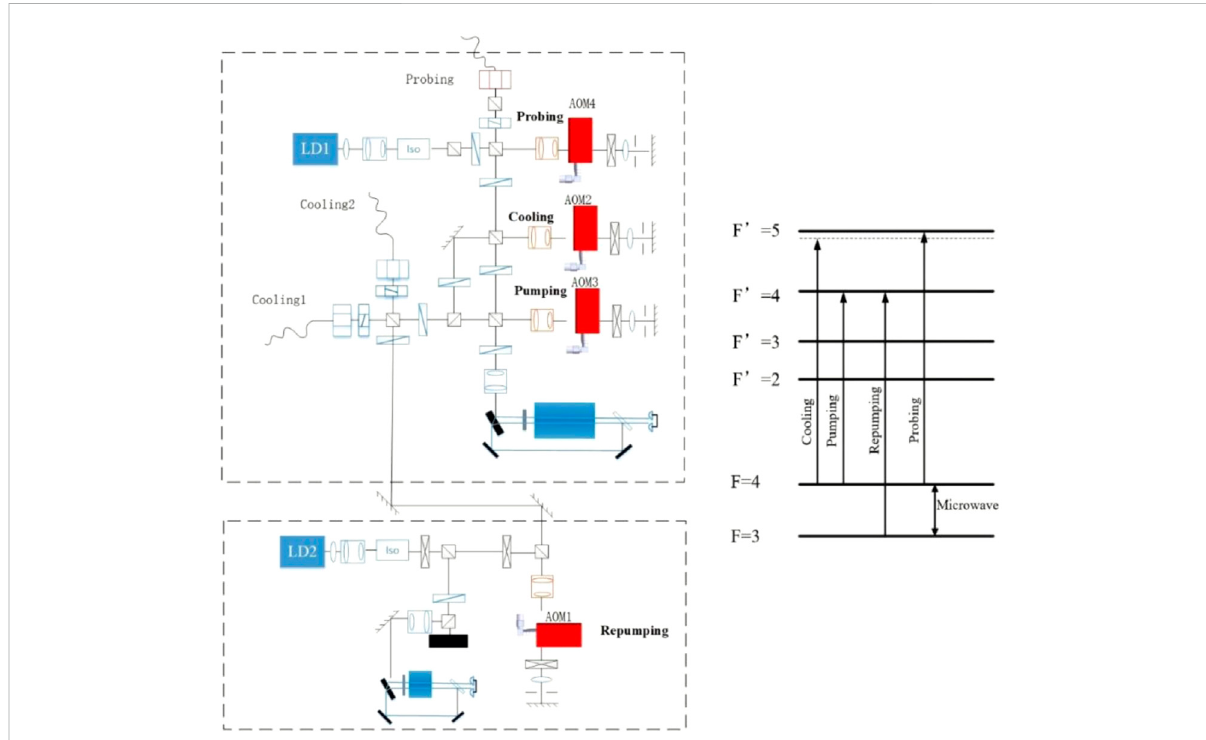
FIGURE 2 Principle of optical systems and energy levels. LD indicates a laser diode, AOM indicates an acoustic optical modulator, and Iso indicates an isolator.LD1isusedforcooling,probing,andpumping.LD2isusedonlyforrepumping.Bothlasersarelockedbysaturationspectroscopyandshifted by